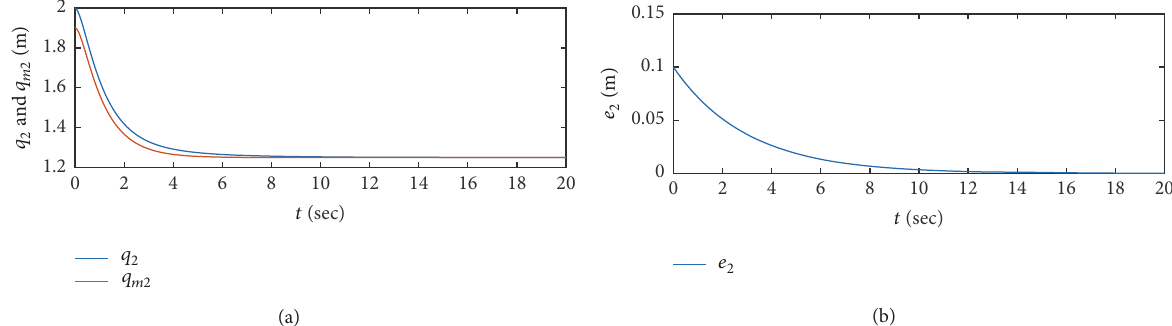
Figure 2: (a) The output of tracking of joint 2. (b) The output of tracking error of joint 2.